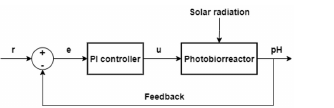
Figure 4. Control scheme of the Proportional–Integral (PI) control